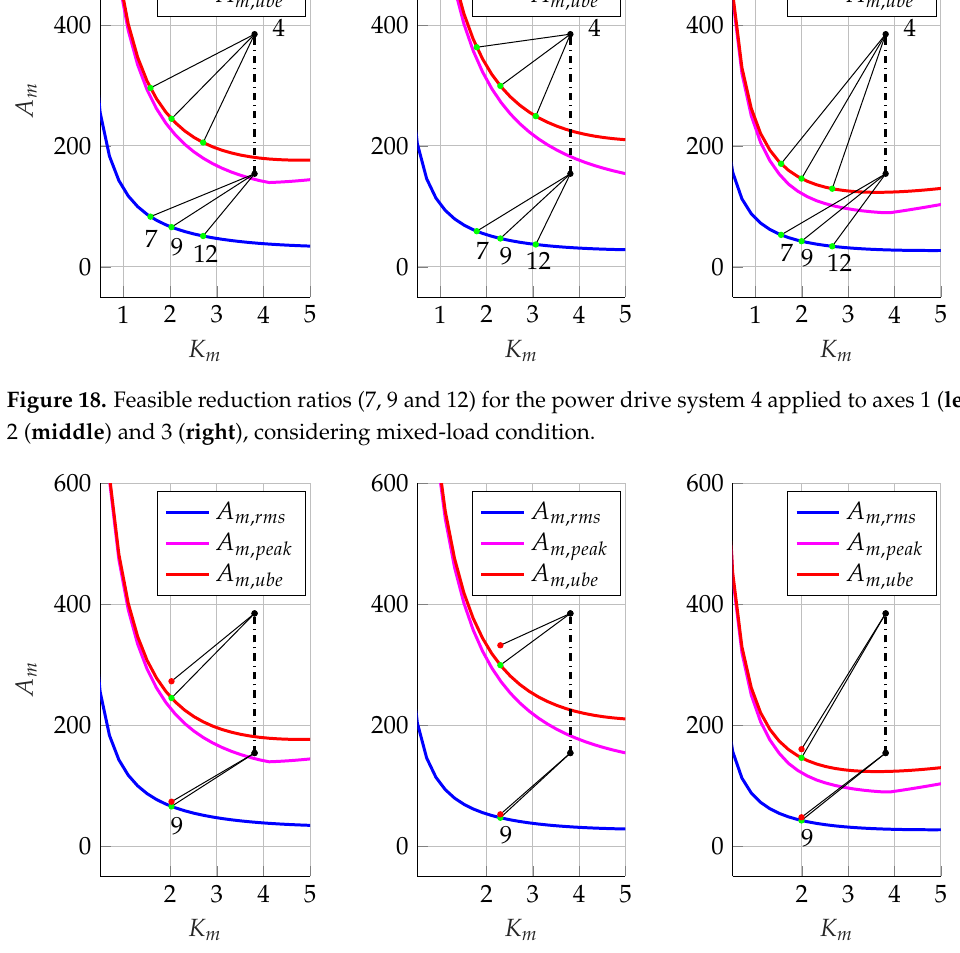
Figure 19. Comparison (for axes 1, 2 and 3, from left to right ) between an ideal and a non-ideal transmission having reduction ratio i t = 9; mixed-load condition. The green points correspond to the ideal transmission, while the red ones to the non-ideal